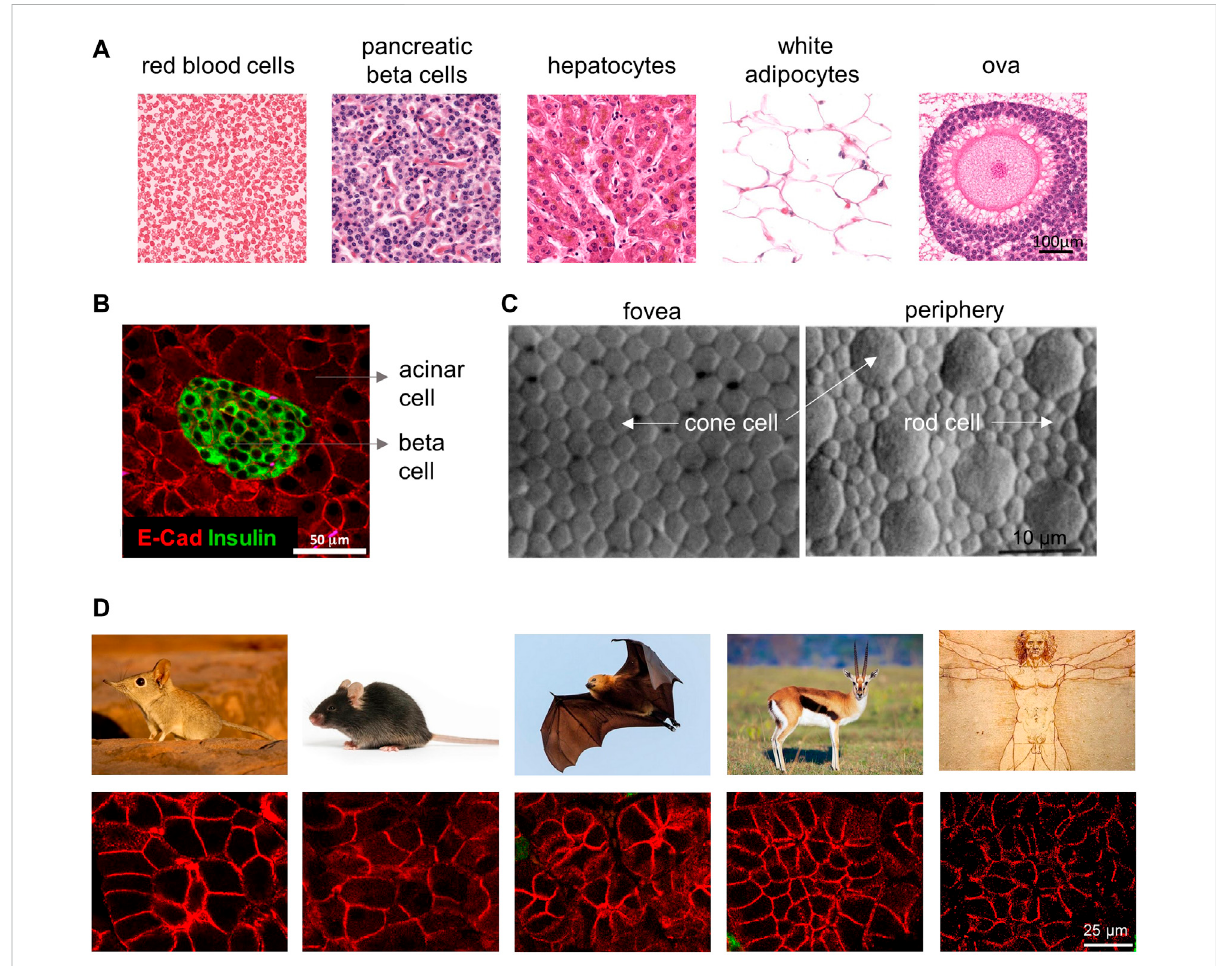
FIGURE 1 Cellsizedifferencesamongdifferentcelltypesandspecies . (A) Inthehumanbody,cellsofdifferentcelltypescanvarysigni fi cantlyintheir size. Cell images are shown at the same magni fi cation, adapted with permission from HistologyGuide.org. (B) Cell size differences in murine pancreatic cells. Note the pancreatic beta cells in the islet (insulin positive) have much smaller size than the surrounding acinar cells (insulin negative).Adaptedfrom(Anzietal.,2018). (C) Cellsizeintheretinanotonlydiffersbycelltype(conevs.rod)butalsobythelocationinthetissue (foveavs.periphery).Notethattheconecellsaresmallerinthefoveathanonesintheperiphery,whichdirectlycorrespondswiththeretina ’ slocal visualresolution.Imageisfrom(Curcioetal.,1990). (D) Pancreaticacinarcellsvaryinsizeindifferentmammalianspecies,fromlefttorightarethe Etruscan shrew, mouse, fruit bat, mountain gazelle, and human (tissue section images from Yuval Dor ’ s lab and animal images searched from